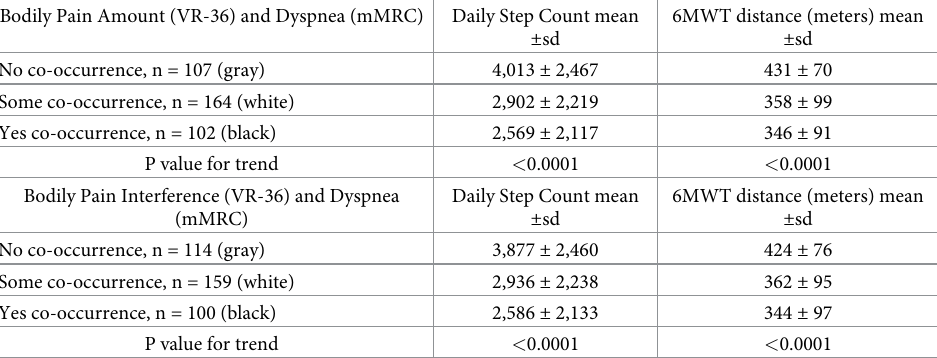
Table 5. a and b. Co-occurring pain and dyspnea are associated with lower daily step count and 6MWT distance. n = 373. Bodily Pain Amount (VR-36) and Dyspnea (mMRC) Daily Step Count mean